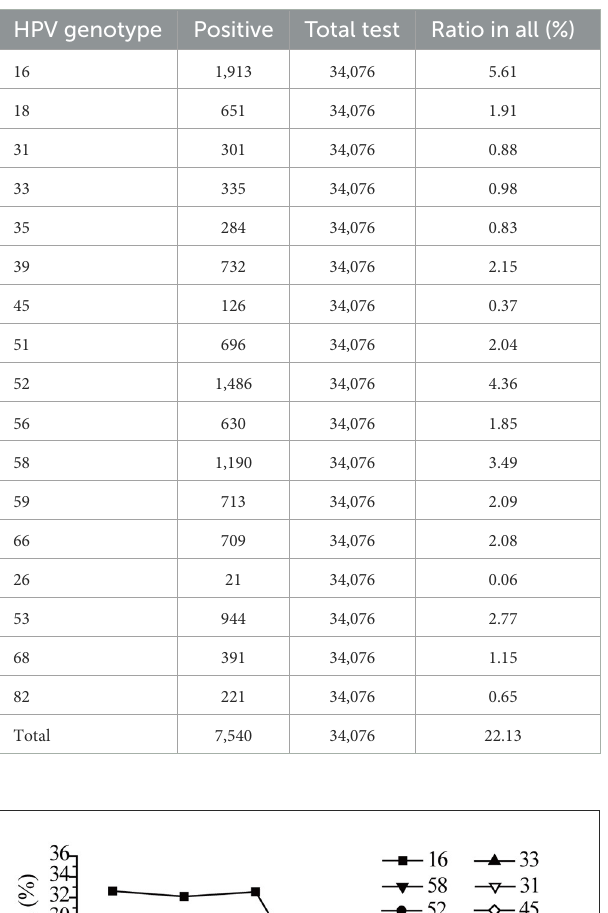
TABLE 1 Prevalence and genotype distribution among 34,076 women. HPV genotype